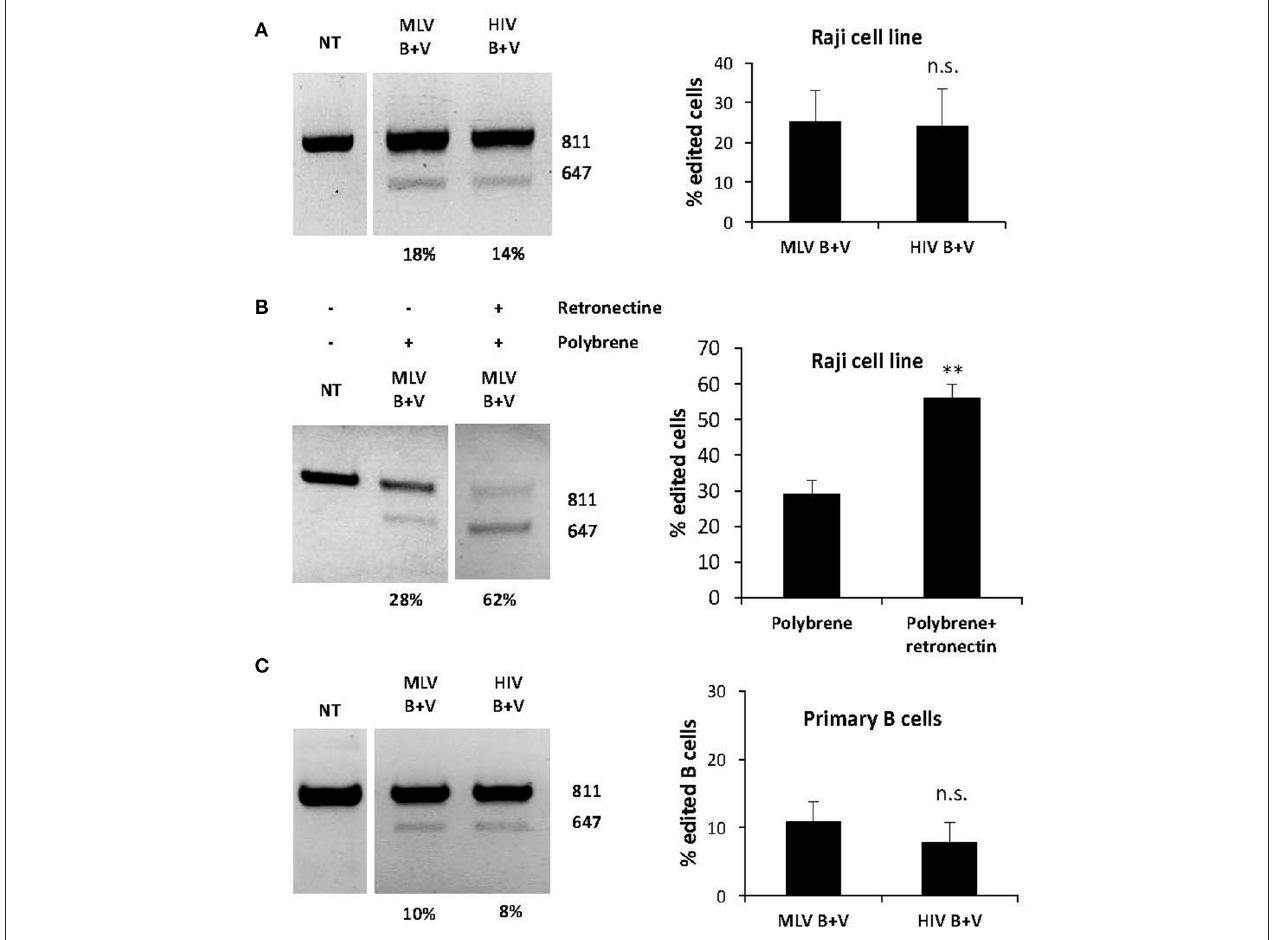
FIGURE 4 | BaEV/VSV-G gp displaying nanoblades allow efficient gene-editing in hB cells. (A) Raji cells transduced with MLV- or HIV-based nanoblades co-pseudotyped with BaEV- and VSVG-gps (B + V). Electrophoresis gel of the PCR product using WASFw/WASRv primers with the % gene-editing indicated for each lane (left) and summarizing graph showing percentage of gene editing (right) (means ± SD; MLV B + V n = 4, HIV B + V n = 5), (B) Raji cells were treated with polybrene (PB) or with polybrene and Retronectin (PB + R) and then incubated with MLV nanoblades co-pseudotyped with B + V. Electrophoresis gel of the PCR product using WASFw/WASRv primers with the % gene-editing indicated for each lane (left) Graph showing percentage of gene editing (right) (means ± SD; MLV B + V n = 3, HIV B + V n = 3; student t -test, ** p < 0.01, n.s., not significant). (C) Primary human B cells preactivated with Pansorbin A and IL-2 were incubated with MLV or HIV nanoblades co-pseudotyped with BaEV- and VSVG-gps (B + V). Representative gel of the PCR product using WASFw/WASRv primers with the percentage of gene-editing indicated for each lane (left) and graph showing percentage of gene editing (right) (means ± SD MLV B + V n = 3, HIV B + V n = 3; student t -test, n.s., not